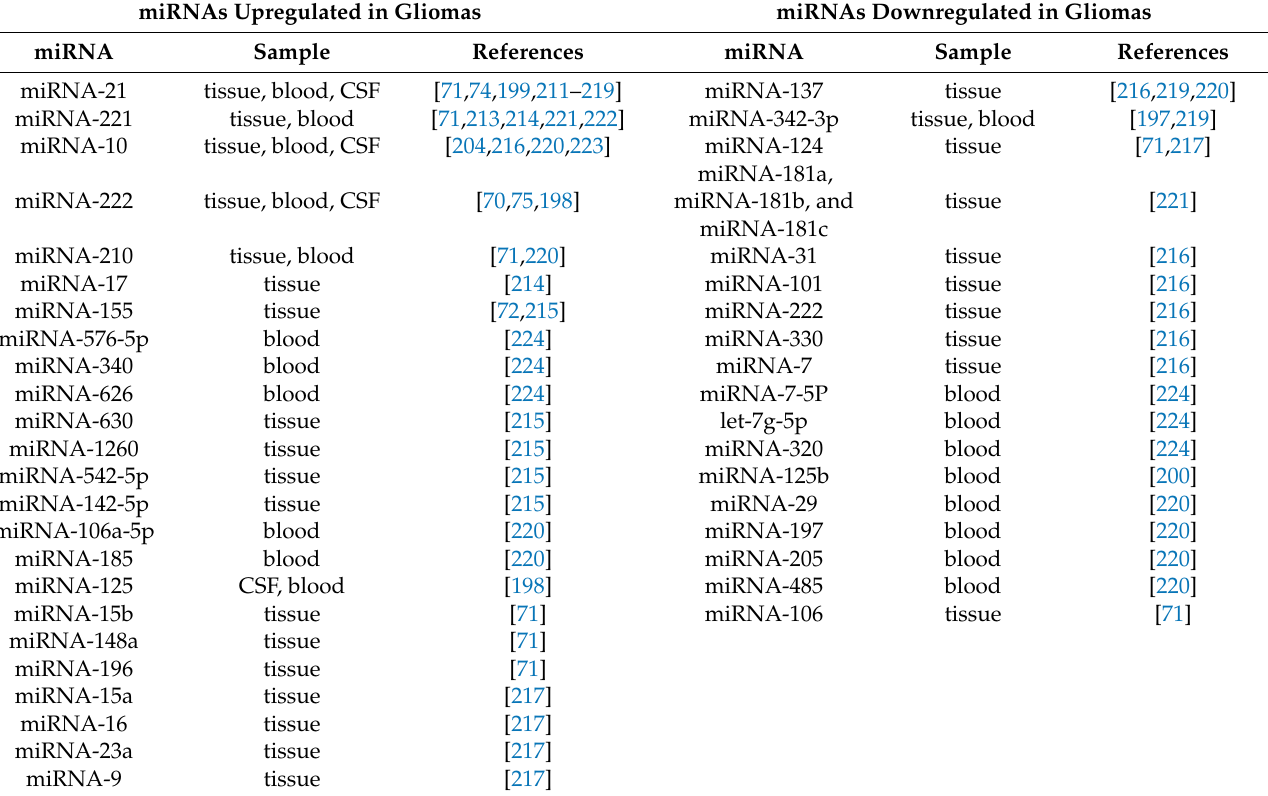
Table 3. Upregulated and downregulated miRNAs in